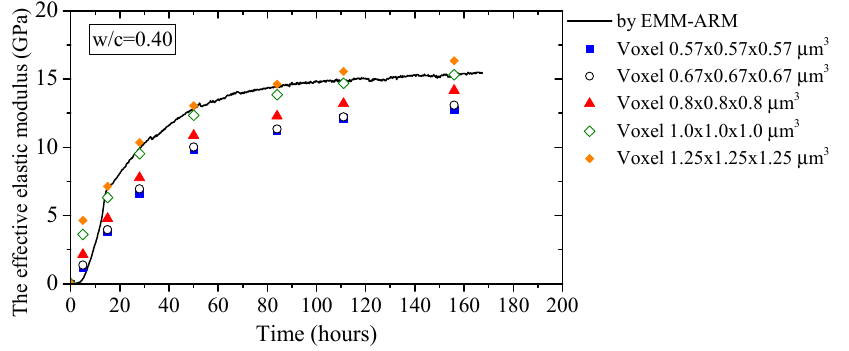
Figure 15. Influence of voxel resolution on the effective elastic Young’s modulus of REV.